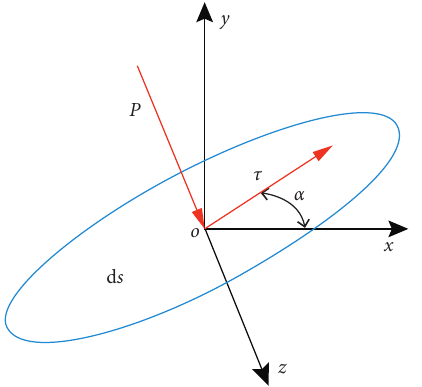
Figure 1: Simplified diagram of sandcastle model section.